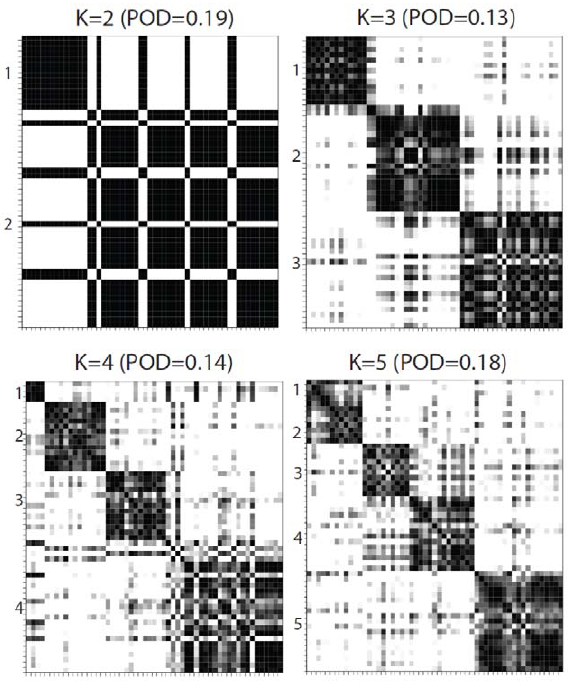
Figure 3. Cluster separability plots in the GBM data set. Proportion of deviation (POD) is calculated as the proportion of deviation from a block diagonal structure. K=3 has the best block- diagonal structure.